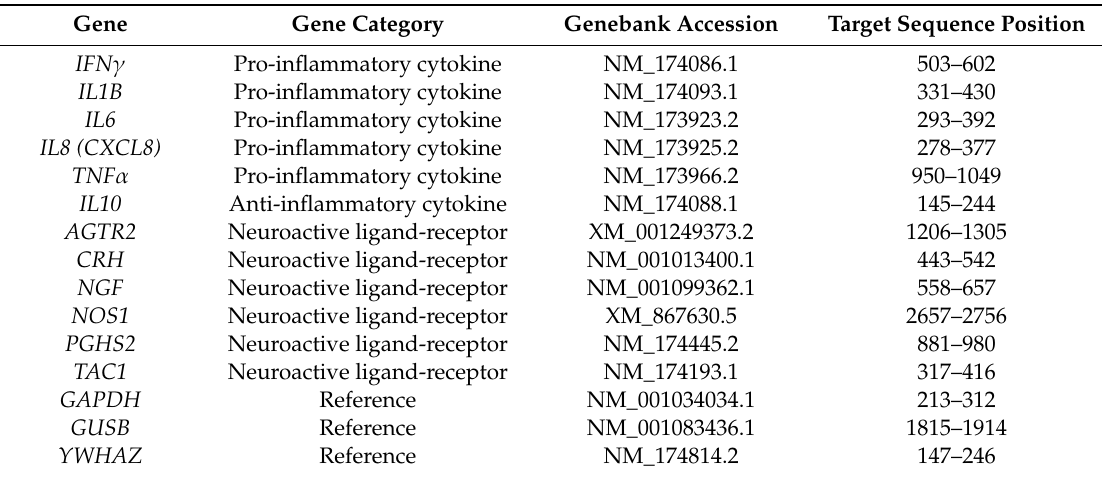
Table 1. Details of genes analysed for transcription in peripheral